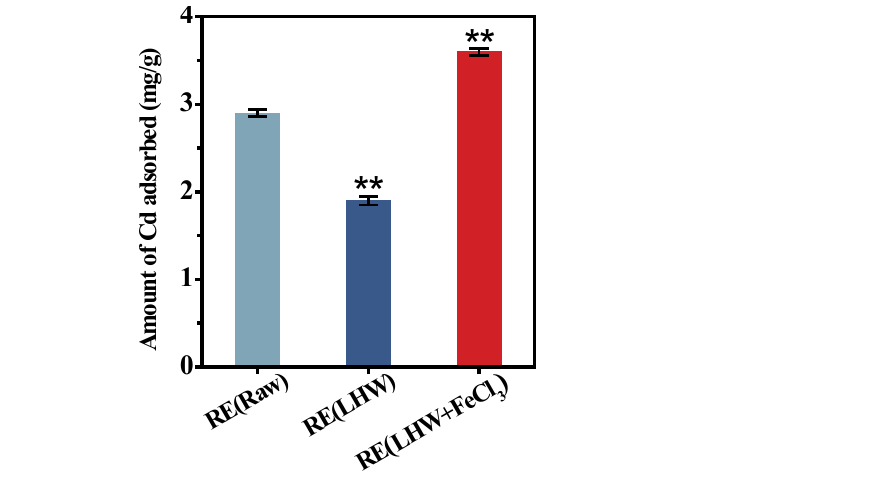
Figure 3. The Cd-adsorption capacity with the enzyme-undigestible residues as biosorbent upon the optimal LHW pretreatment co-supplied with/without 4% FeCl 3 in the desirable corn (ZH) cultivar. Data as mean ± SD (n = 3); ** a significant difference between pretreated residues and raw material at p < 0.01 level.